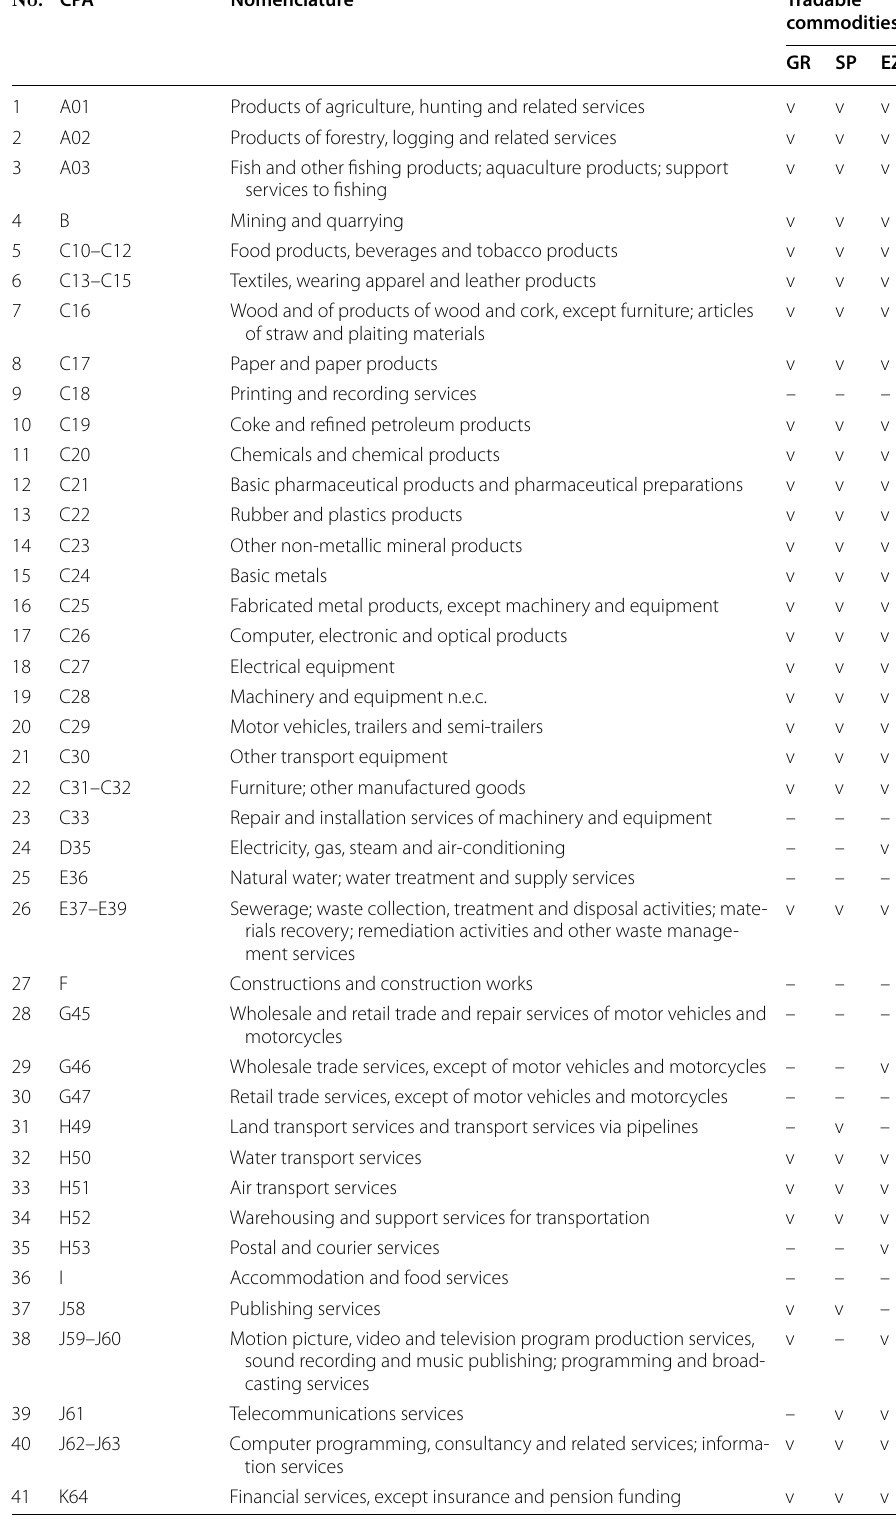
Table 7 Product classification and tradable